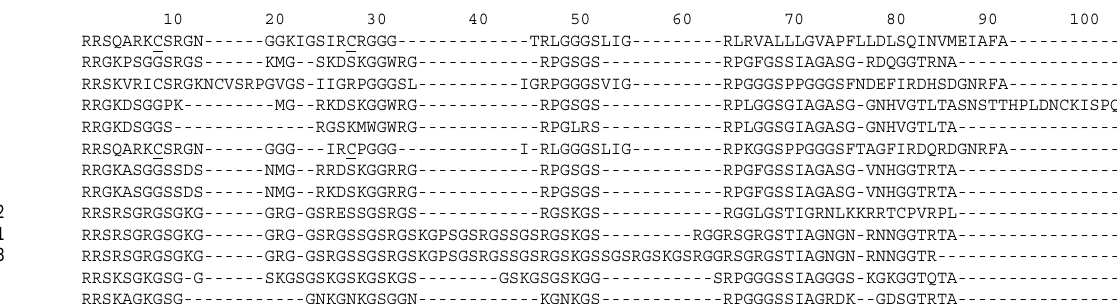
Figure 4. Alignment of fish cathelicidins. Mature peptide sequences were obtained from published data and from the PubMed protein database, and were aligned using MacVector software. Characteristic cysteine residues found in certain classes of fish cathelicidins are underlined. As, Atlantic salmon; Rt, Rainbow trout; Cs, Chinook salmon; Btr, Brown trout; Ac, Arctic char; Bt, Brook trout; Je, Japanese